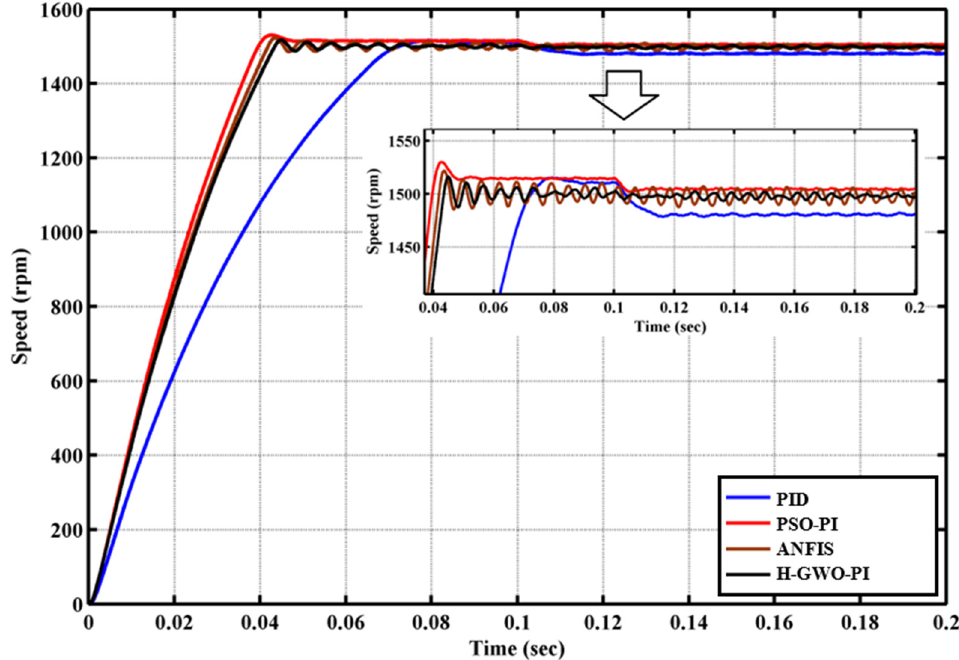
Figure 11. Response of the Brush-less DC motor in terms of speed under Case A. Table 3. Performance parameters for Case A condition.